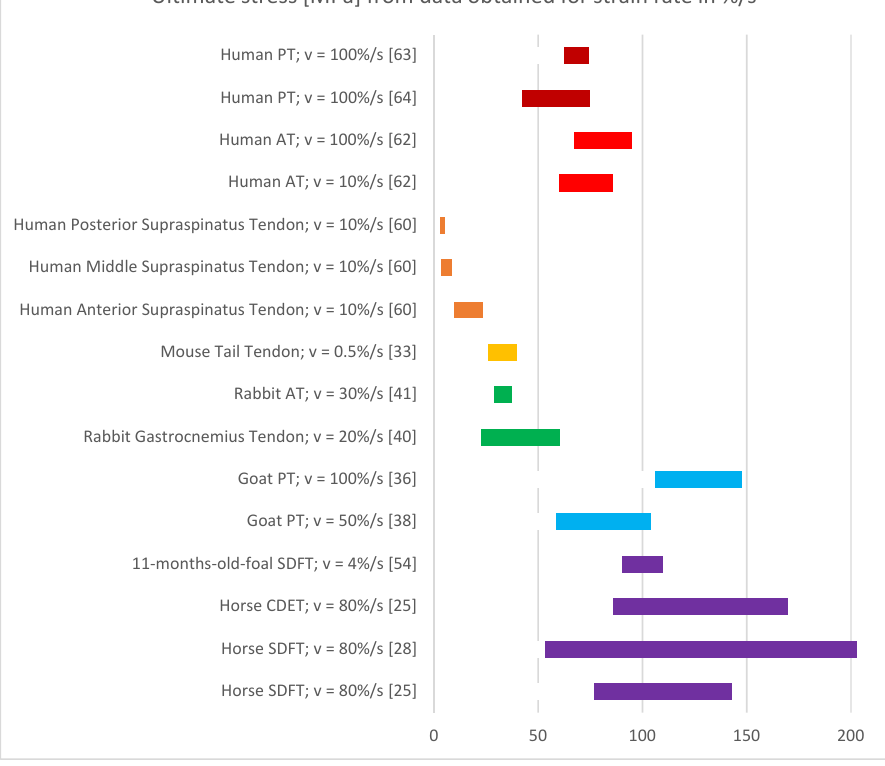
Figure 6. Ultimate stress for the considered animal species (%/s).